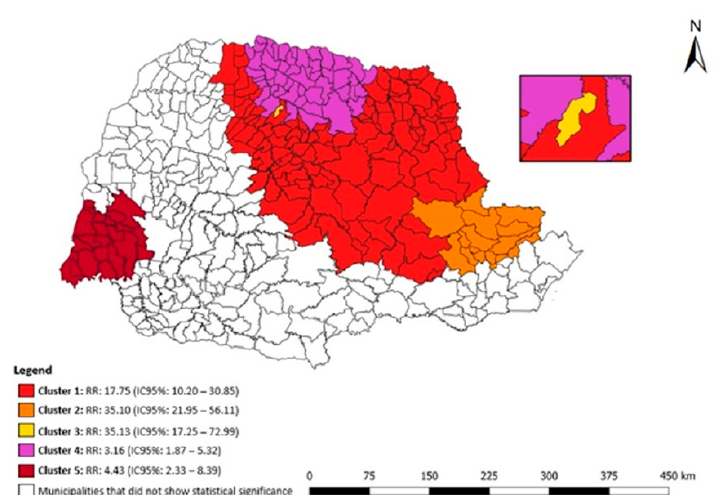
Figure 5. Areas of spatial risk for DR-TB in the liberty-deprived population in the state of Paraná, Brazil, 2008 to 2018.